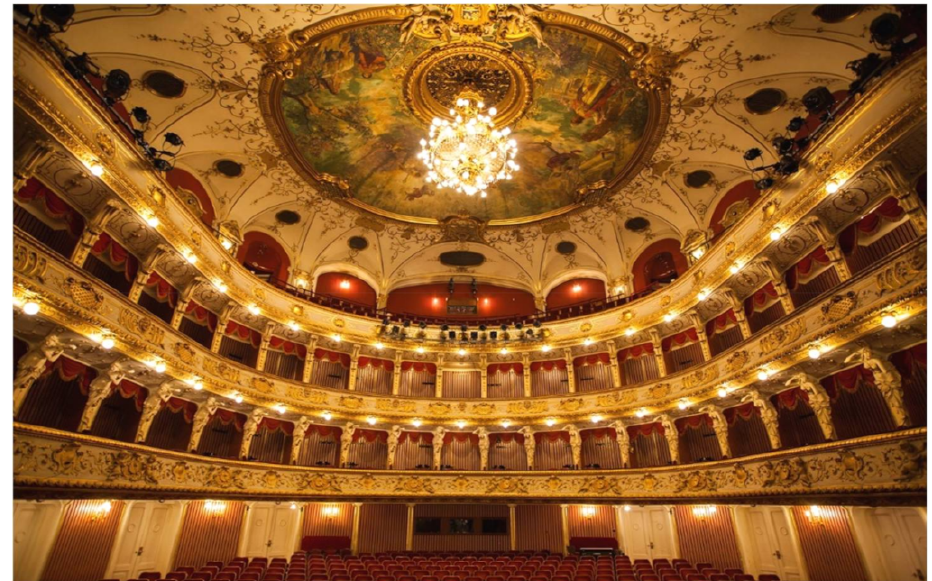
Figure 3. View of the main hall from the stage.